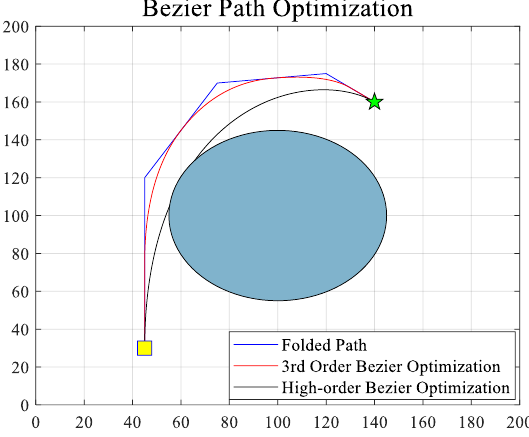
Figure 5. B é zier curve optimization Figure 5. Bézier curve optimization schematic.